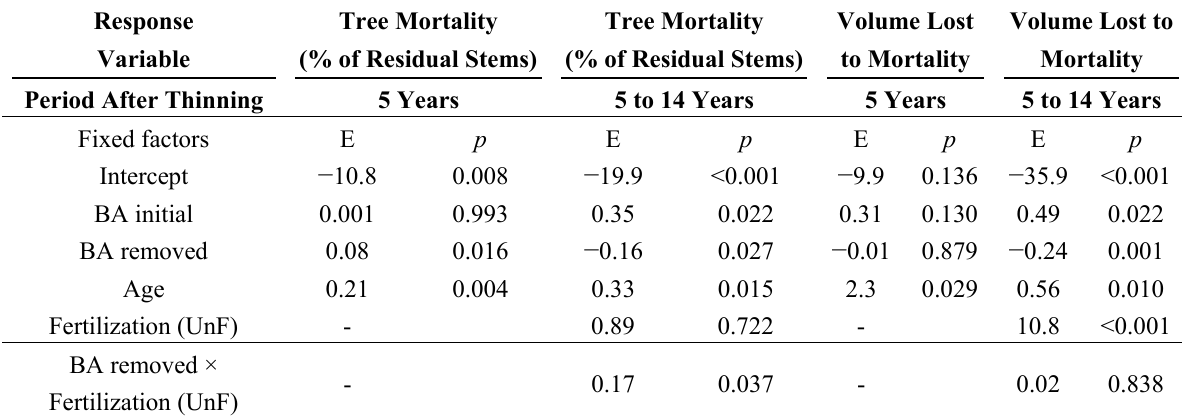
Table 3. Stand level tree mortality in commercially thinned jack pine stands with or without fertilization over periods of 5 and 5 to 14 years following thinning. Fertilization was conducted within experimental sub-plots 3 to 5 years after thinning. Effects of initial stand basal area and age, basal area removed by commercial thinning, fertilization and selected interactions on mortality assessed by means of mixed linear